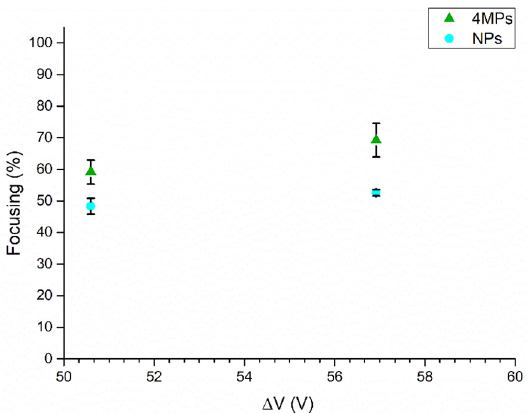
Figure 8. UV–Vis characterization of focusing performance of the BAW device when a mixed population of 4MPs concentrated at 2.84 × 10 5 particles/mL and NPs concentrated at 1.82 × 10 5 particles/mL was injected at 1 µ L/min into the device, which was actuated at its resonance frequency of 4.623 MHz. Experiments were performed by applying 50.59 Vpp and 56.92 Vpp at the transducer.